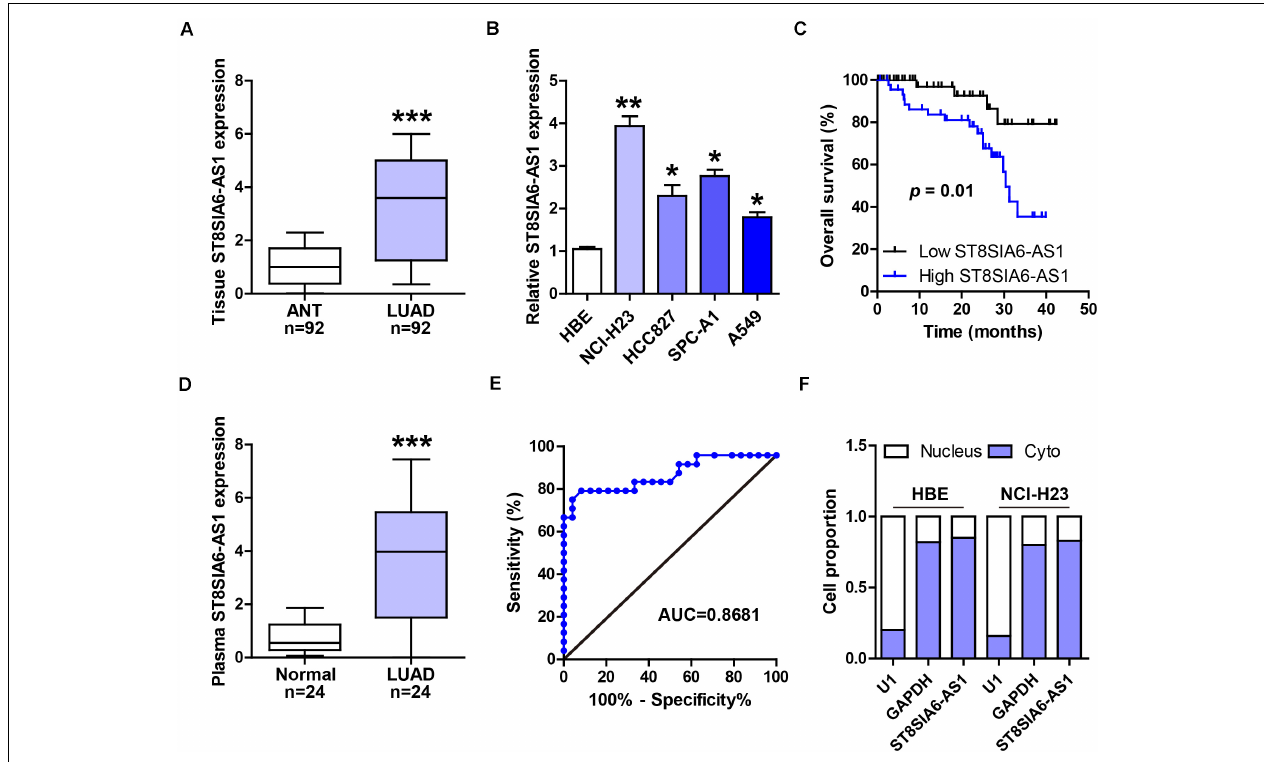
FIGURE 1 | ST8SIA6-AS1 is overexpressed in LUAD. (A,B) qRT-PCR analysis of ST8SIA6-AS1 expression in LUAD tissues and cell lines. (C) The survival curve of LUAD patients with low and high ST8SIA6-AS1 level. (D) qRT-PCR analysis of ST8SIA6-AS1 expression in LUAD plasma. (E) ROC curve analyzing the diagnostic value of plasma ST8SIA6-AS1 for LUAD. (F) qRT-PCR analysis testing the location of ST8SIA6-AS1 in HBE and NCI-H23 cells. * P < 0.05, ** P < 0.01, *** P < 0.001.